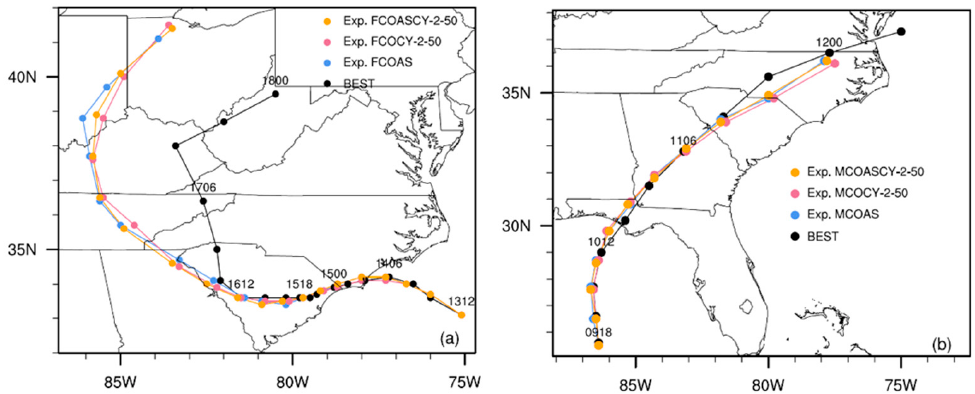
Figure 6. Forecast track of all assimilation experiments against the NHC best-track data (BEST) for Florence and Michael. ( a ) Florence (1200 UTC 13 to 0000 UTC on 18 September 2018); ( b ) Michael (1800 UTC 9 to 0000 UTC on 12 October 2018).